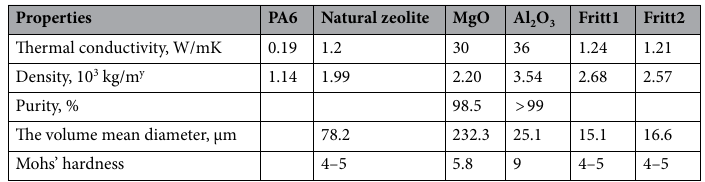
Table 3. Properties of PA6 and different